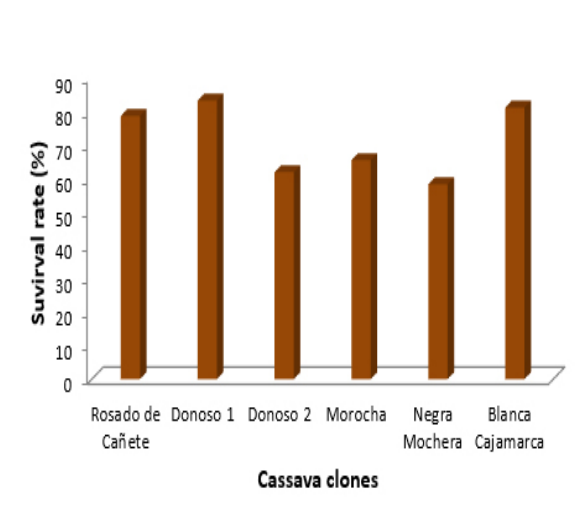
Figure 1. Percentage of stake survival of cassava clones in the final field